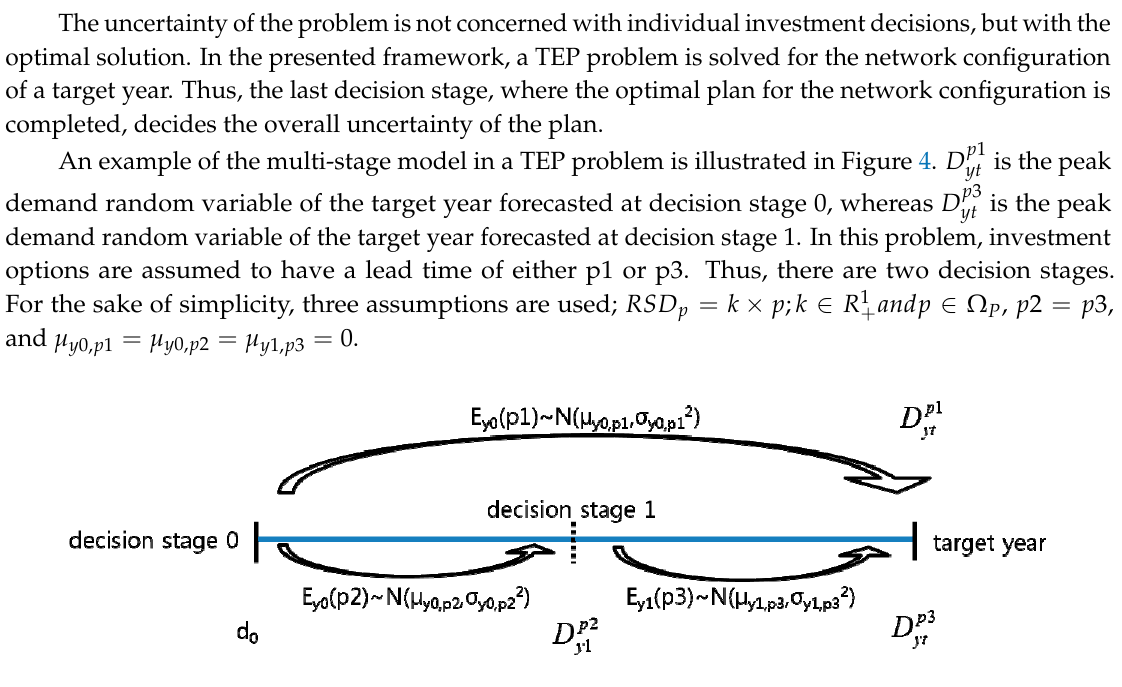
Figure 4. Example of multi-stage model in a TEP problem.